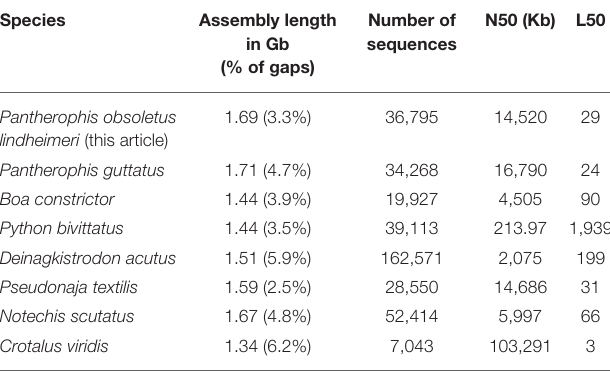
TABLE 2 | Statistics of the final Texas rat snake genome assembly compared to other published snake